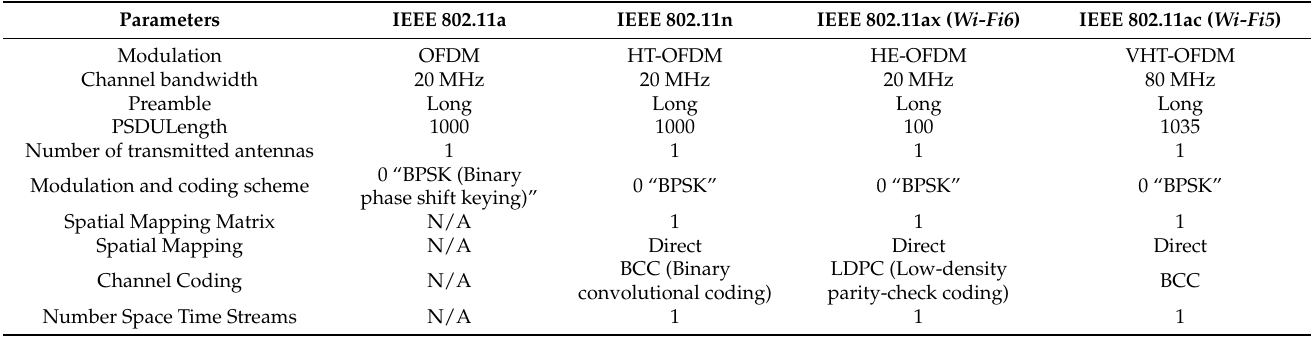
Table A1. WLAN standards simulation